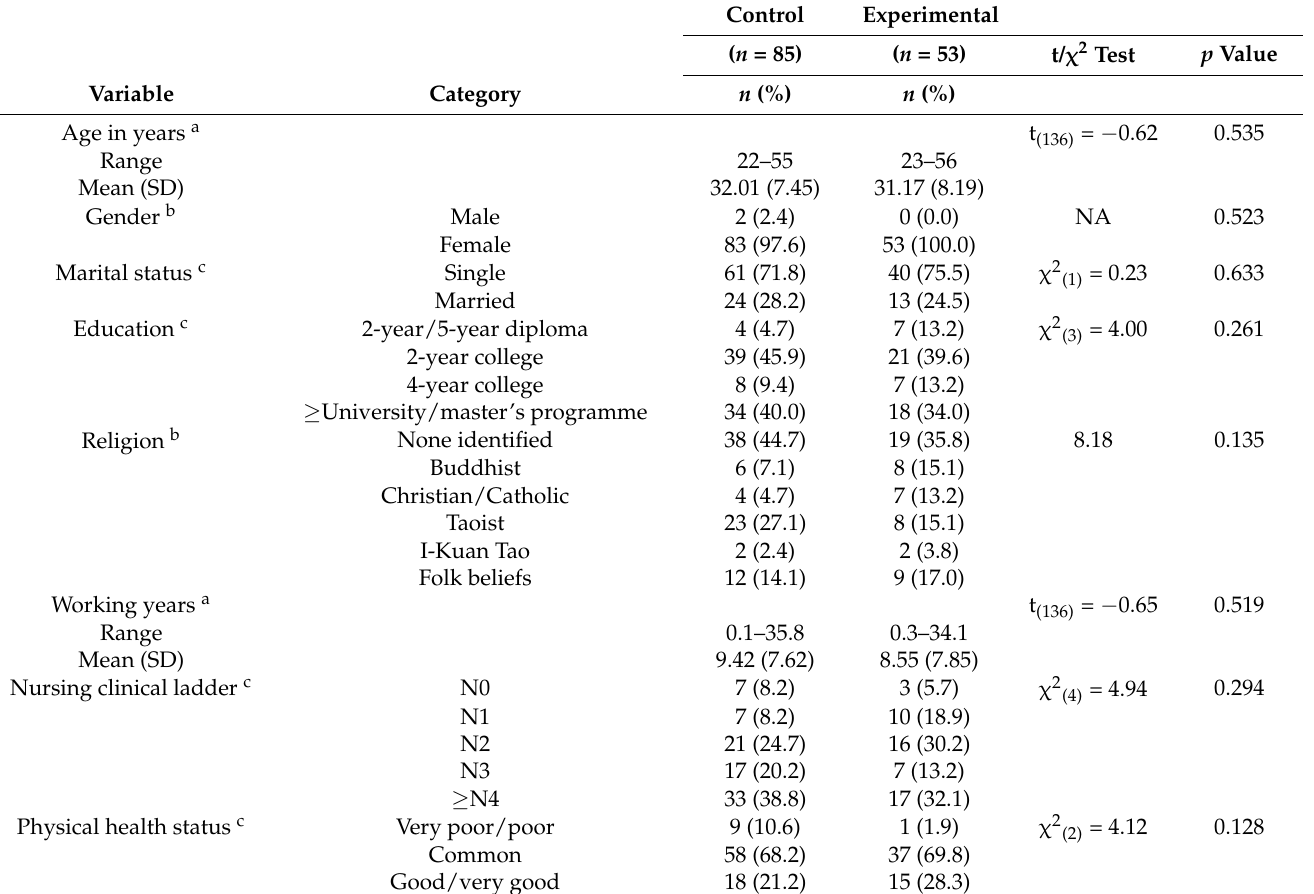
Table 3. Homogeneity test of sociodemographic variables of clinical nurses by group at baseline ( n =